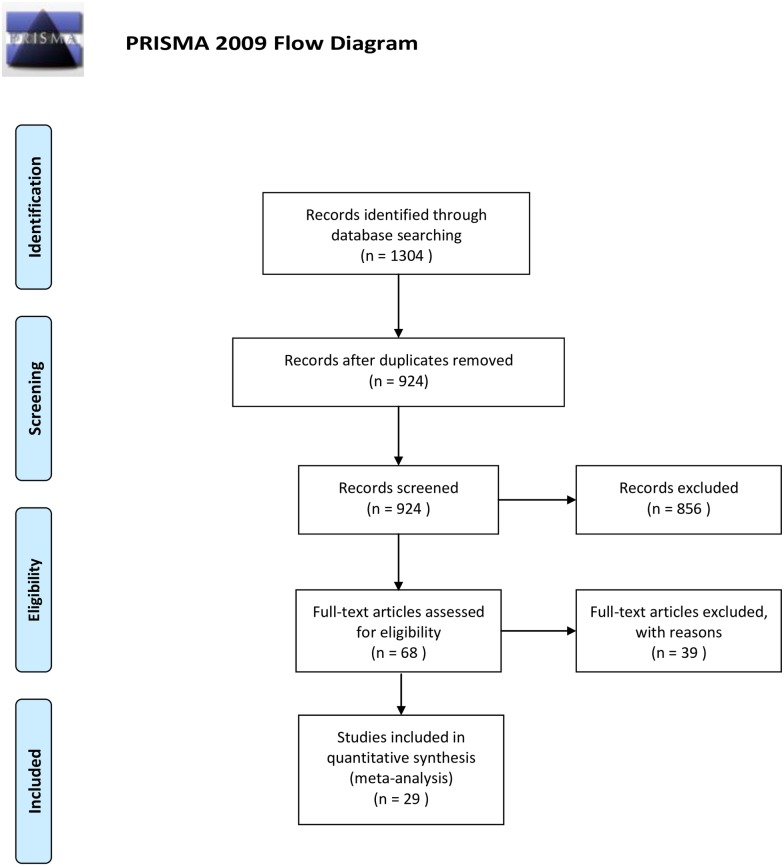
Literature screening flow diagram.From: Moher D, Liberati A, Tetzlaff J, Altman DG, The PRISMA Group (2009). Preferred Reporting Items for Systemetic Reviews and Meta-Analyses: The PRISMA Statement. PLoS Med 6(7): e1000097. doi:10.1371/journal.pmed1000097. For more information, visit www.prisma-statement.org.